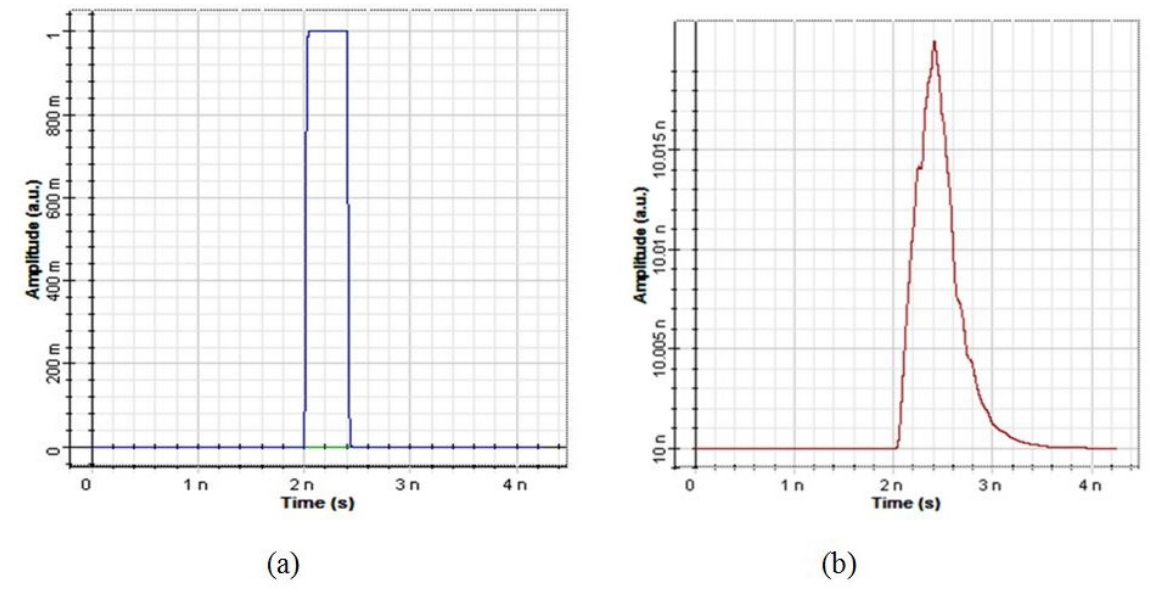
Figure 12. Simulation results from a single LED NLOS propagation model. ( a ) Input signal. ( b ) Output signal.